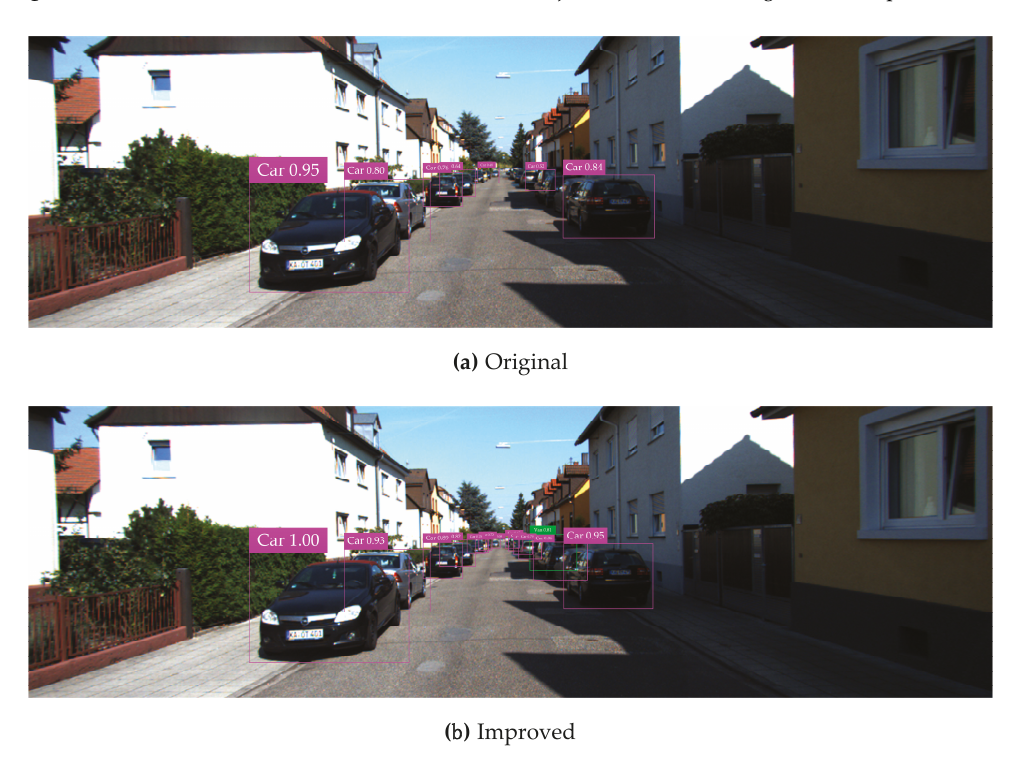
Figure 10. Vehicle detection test results under occlusion based on the original and improved